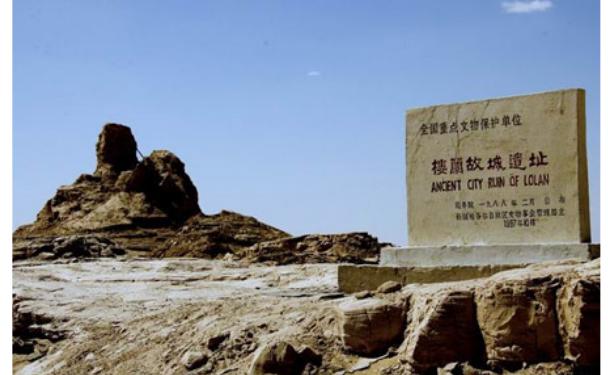
Fig. 6. Ruins of Lolan, which was abandoned around the 6th century AD (adapted from http://info.hotel.hc360.com/2010/06/